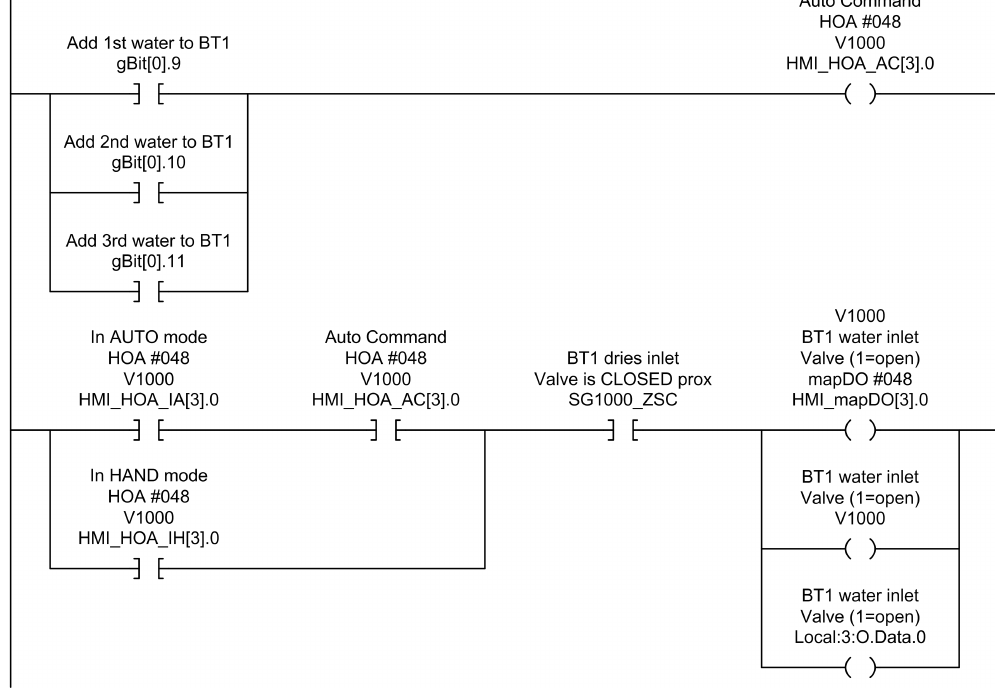
Figure 5. Typical rungs for a discrete output, new